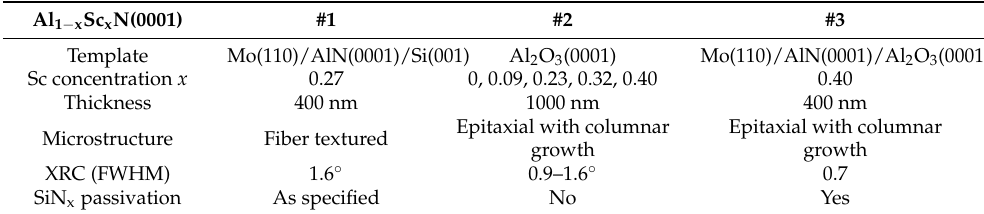
Table 1. Summary of all thin film samples investigated in this